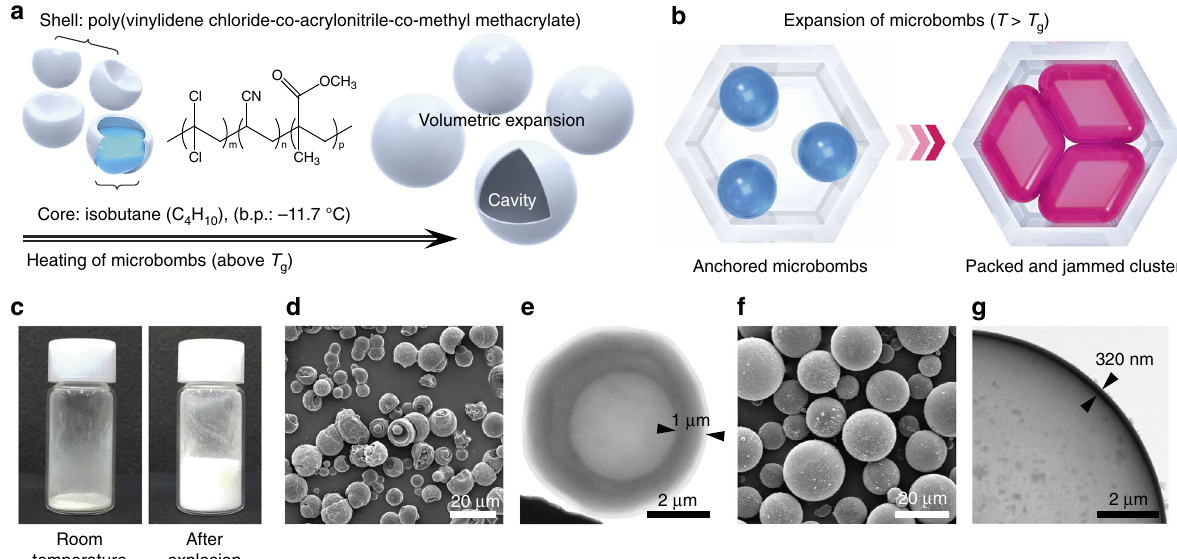
Fig. 1 Packing and jamming of microbombs within micro-con fi nement. a Illustration of microbombs consisting of an isobutane core and a polymeric shell, which explode and release the isobutane upon heating. b Spontaneous packing and jamming of microbombs inside microwells at a temperature above T g . c Photos of the microbombs in a vial before and after the volumetric expansion. d – g Scanning electron microscopy (SEM) images of the microbombs before ( d ) and after ( f ) explosion, and the corresponding transmission electron microscopy (TEM) images showing the shell thickness before ( e ) and after ( g )